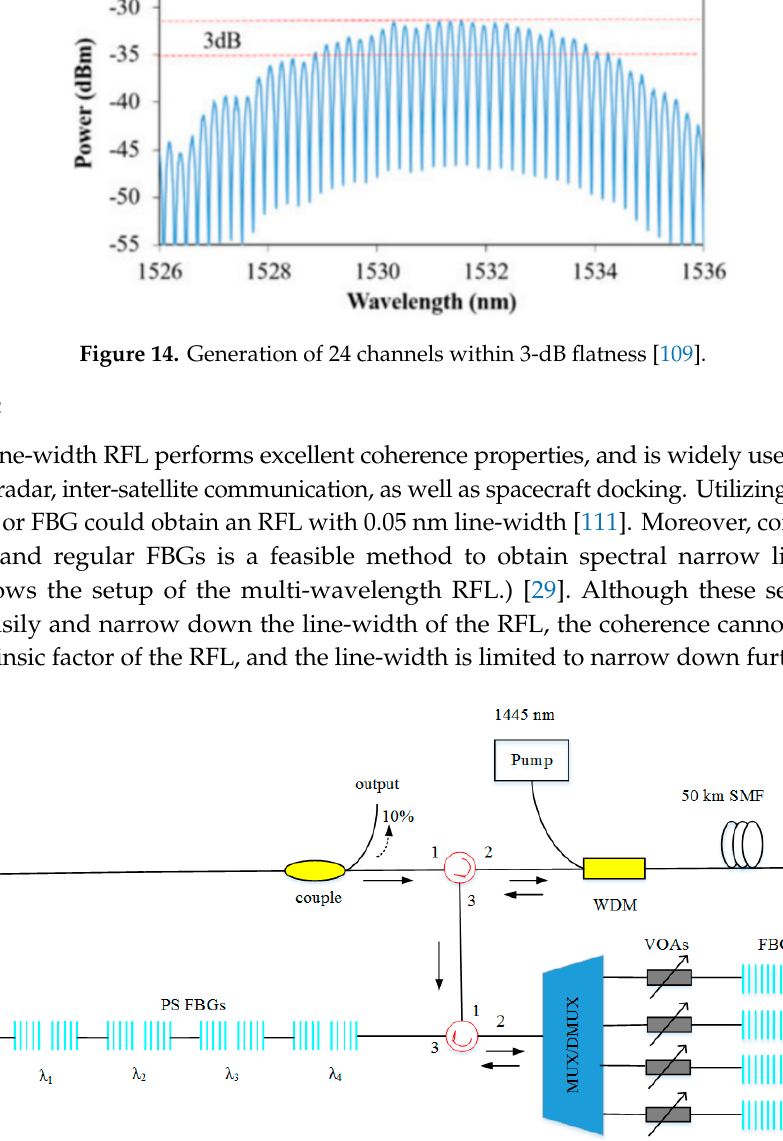
Figure 15. Setup of the multi-wavelength RFL. PS FBGs, phase-shifted fiber Bragg gratings; VOA, variable optical attenuators; MUX/DMUX, multiplexer/demultiplexer.